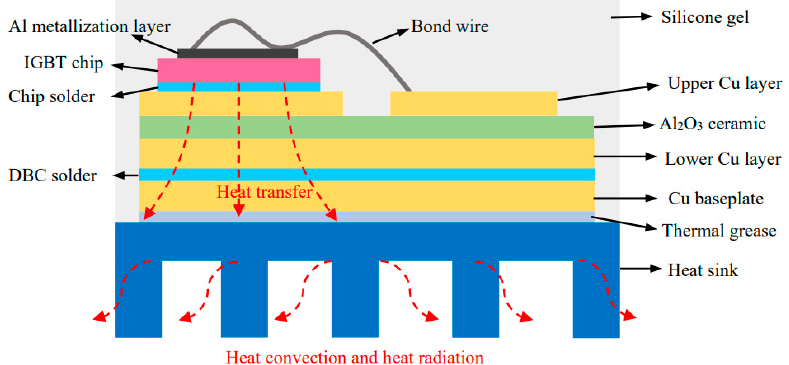
Figure 2. Schematic diagram of the heat transfer process of the IGBT module.